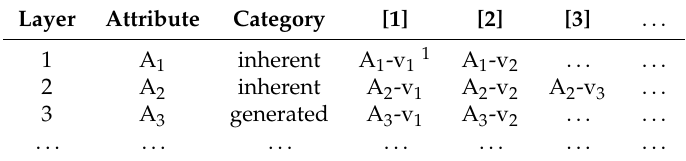
Table 1. Attribute structure.